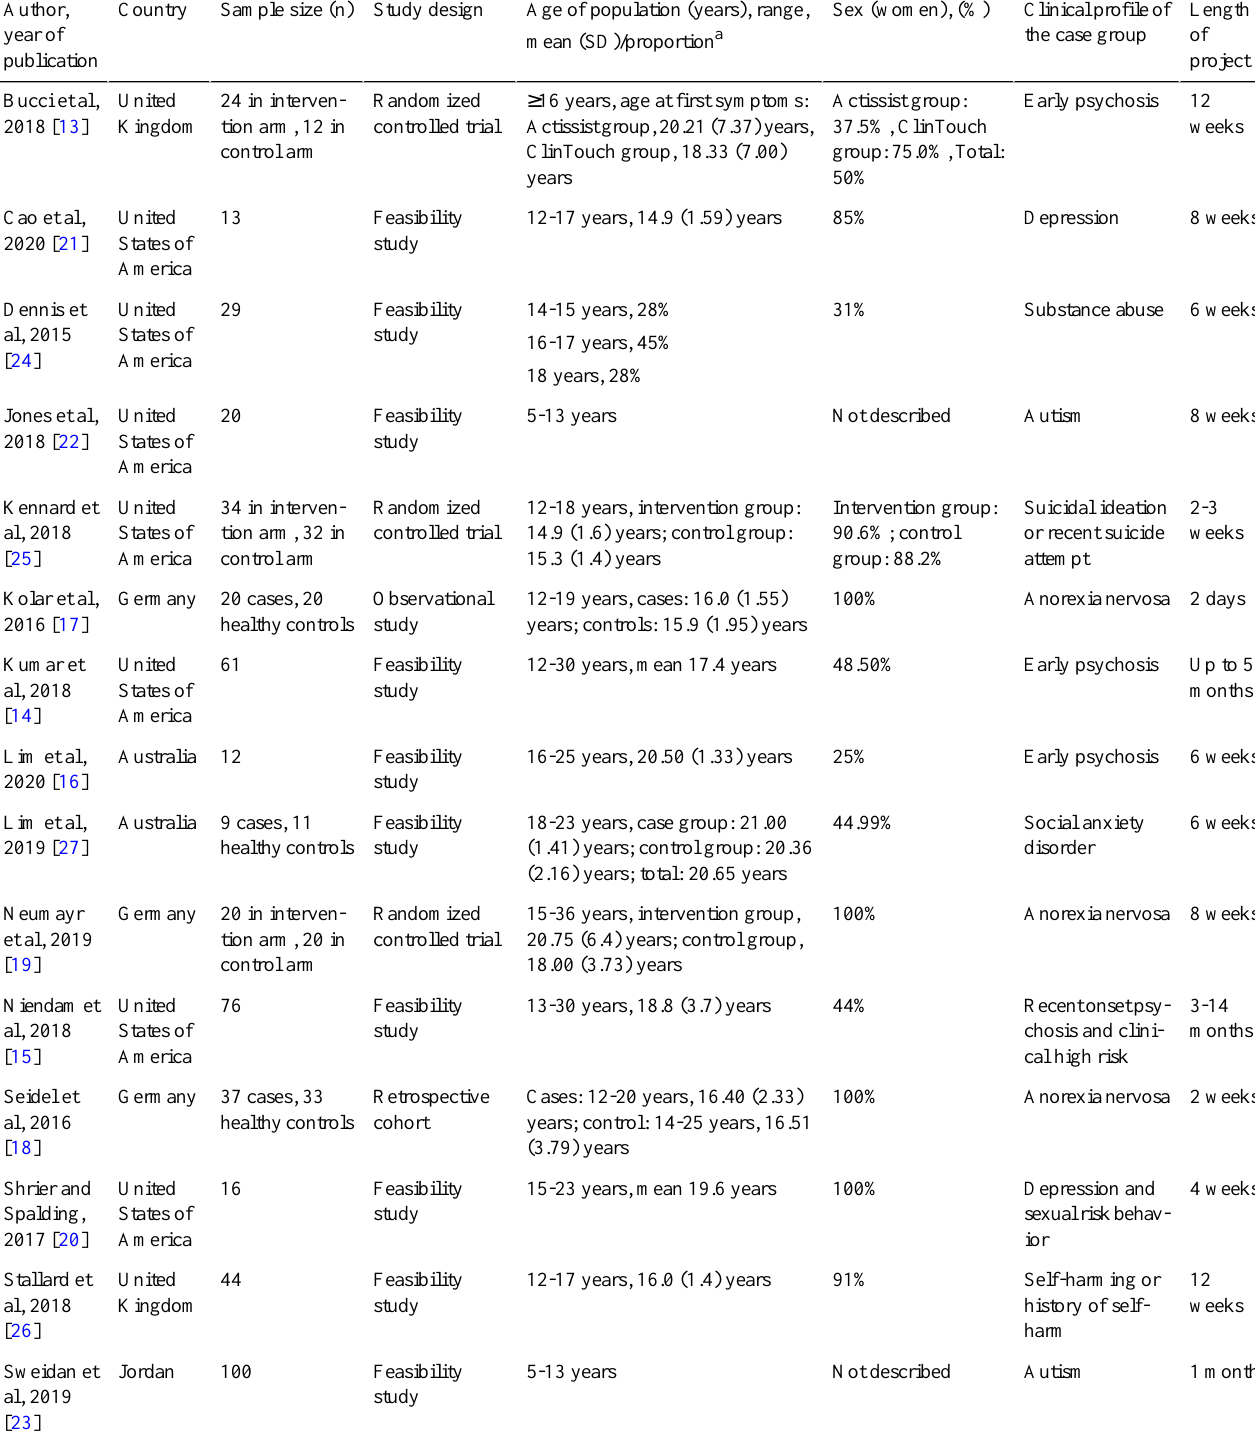
Table 1. Description of the study design and populations of studies on self-monitoring and automatically generated data collected via smartphones in children, adolescents, and young adults with psychiatric disorders (N=15).